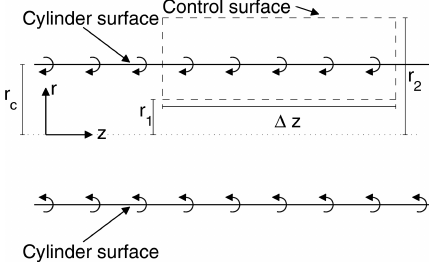
Figure A3. A 2D cut of the vortex surface with definition of rect- angular control